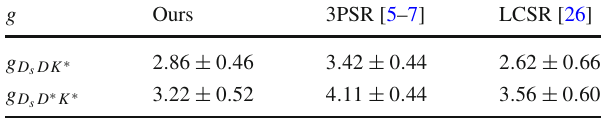
Table 7 Values of the coupling constant using the LCSR, and 3PSR